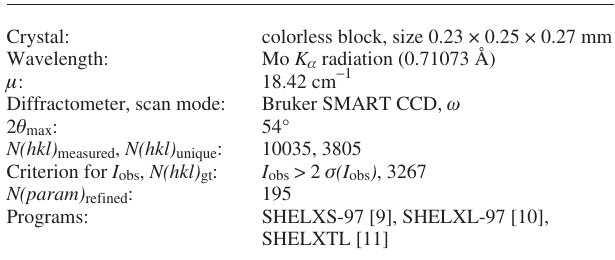
Table 1. Data collection and handling.